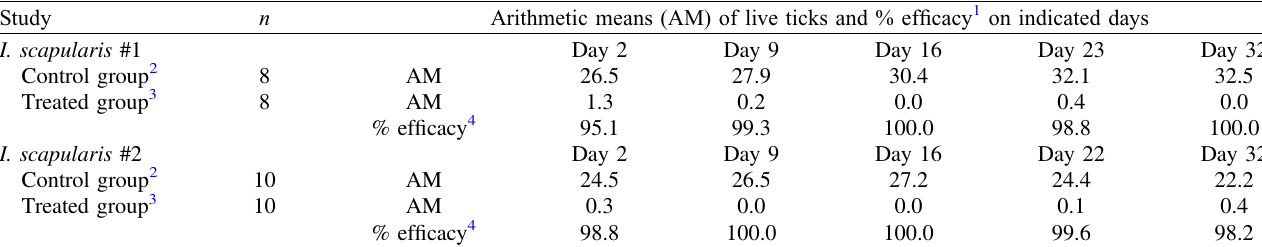
Note : p -values 5 for comparison of the untreated and treated groups = <0.0001 at all time-points. n = number of cats per group. 1 The I. scapularis counts were analyzed using SAS Version 9.4. The logarithm of the (count + 1) was analyzed at each study day separately using the MIXED procedure with treatment group used as a fi xed effect and blocks used as a random effect. 2 Control group = Mineral oil administered topically once on Day 0 at 0.12 mL/kg 3 Treated group = Novel formulation administered topically once on Day 0 at 0.12 mL/kg, providing 1.4 mg/kg esafoxolaner, 10.0 mg/kg praziquantel and 0.5 mg/kg eprinomectin 4 Percent ef fi cacy = [( C – T )/ C ] (cid:3) 100, where C and T are the arithmetic means of the control and treated groups, respectively. 5 Two-sample probability value comparing the population means of the treated group vs. the control